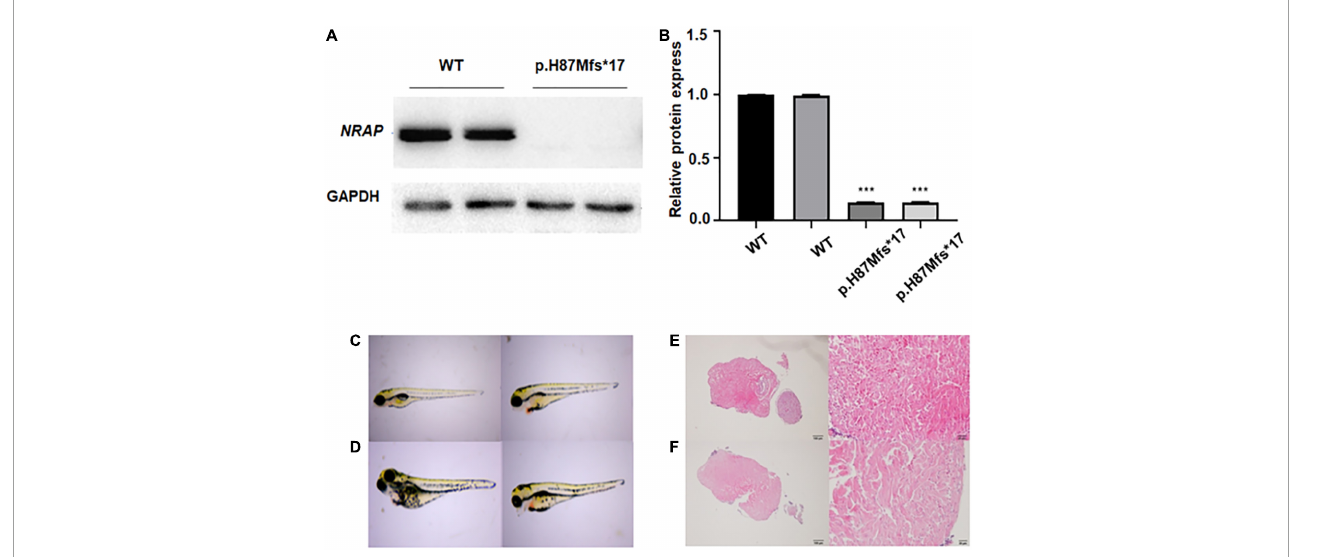
FIGURE2 Functional study of p.H87Mfs*17 mutation in nebulin-related-anchoring protein (NRAP). (A) Total cell protein expressions of wild-type (WT) vs. the mutated NRAP determined by Western blotting. p.H87Mfs*17 mutation led to decreased expression of NRAP. (B) Quantitative analysis of total cell protein expressions of WT vs. mutated NRAP. All values are means ± SD; n = 6 in each group. *** P < 0.001 vs. control. (C,D) Images of juvenile fish with pericardial edema. Two cases were the wild-type (WT) zebrafish (C) and two cases carried a homozygous mutation of the NRAP allele (D) . (E) HE-stained heart tissue of normal zebrafish. (F) HE-stained heart tissue of zebrafish with pericardial